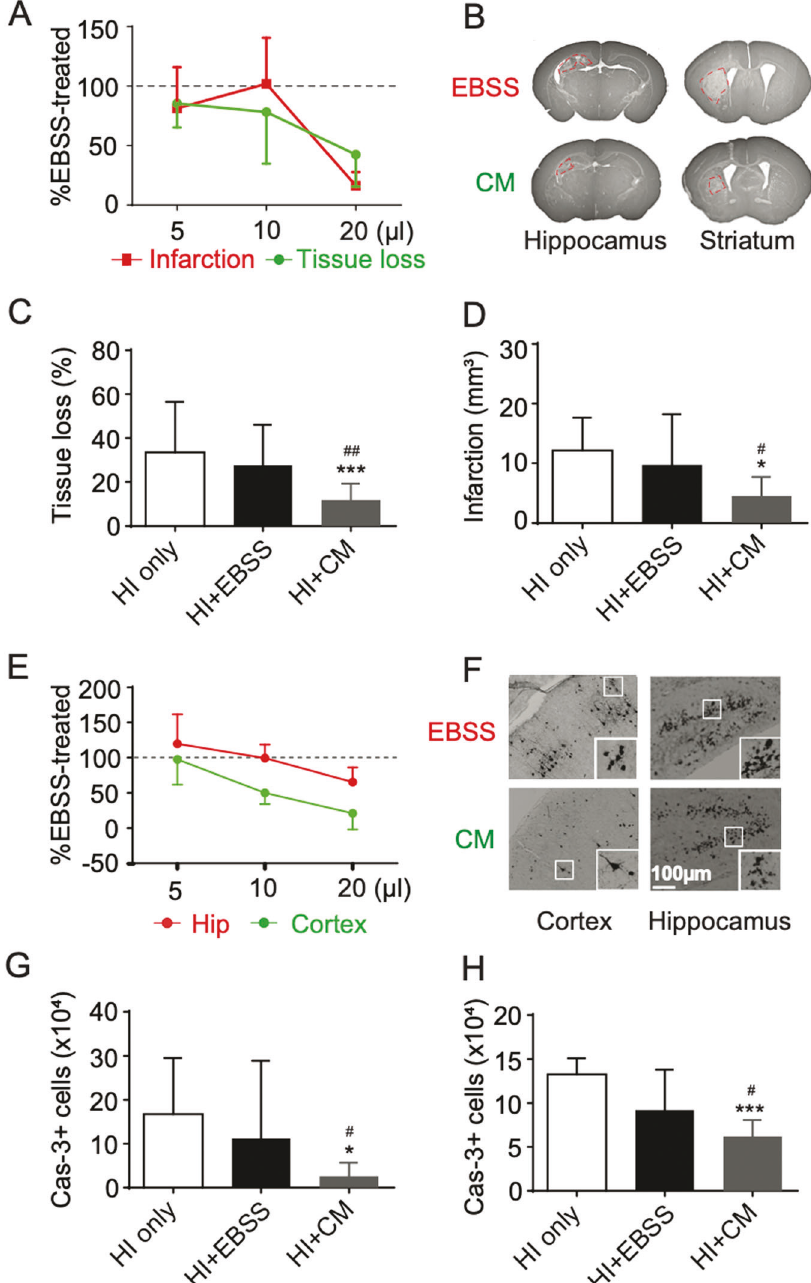
Fig. 5 NSPC-derived CM ameliorates HI-induced brain damage. A The indicated volumes of NSPC-derived CM (hereafter as CM) were injected into the ipsilateral lateral ventricle prior to the induction of HI. Data are expressed as a percentage (%) relative to the corresponding vehicle-treated groups. ** p < 0.01 versus EBSS-treated group in regard to tissue loss; # p < 0.05 versus EBSS-treated group in regard to infarction volume. B Representative MAP2-stained coronal sections at the level of the hippocampus (left column) and striatum (right column) 24 h after HI in mice that were injected with either 20 µl vehicle (EBSS, upper row) or 20 µl CM (lower row). C Tissue volume loss on the ipsilateral hemisphere relative to the contralateral hemisphere, represented as a percentage (0% represents no tissue loss in the ipsilateral hemisphere). D Infarct volume was quanti fi ed in mice that received an intraventricular injection of 20 µl EBSS or CM prior to HI. * P < 0.05, ** P < 0.01 compared with HI only group. # P < 0.05, ### P < 0.001 compared with EBSS-treated group. n = 6, 17 and 23 mice in the HI only, EBSS and CM groups, respectively. E The number of active caspase-3-positive cells in the cerebral cortex and hippocampus (Hip) was quanti fi ed. Data are expressed as a percentage (%) relative to the corresponding vehicle-treated groups. * p < 0.05 versus EBSS-treated group in cortex; ## p < 0.01 versus EBSS-treated group in hippocampus. F Photomicrographs of re p resentative caspase-3-stained sections of cortex (left column) and dentate gyrus (right column) 24 h after HI in mice that received 20 µl of either vehicle (EBSS, upper row) or CM (lower row). The inserts show high magni fi cation views of the boxed regions. G , H The number of active caspase-3-positive cells in the cortex ( G ), hippocampus ( H ) in mice that received an intraventricular injection of 20 µl EBSS or CM prior to HI was quanti fi ed. The data are presented as the mean ± SD. * p < 0.05, *** p < 0.001 compared with HI only group. # P < 0.05 compared with EBSS-treated group. n = 6, 17 and 23 mice in the HI only, EBSS and CM groups, respectively.